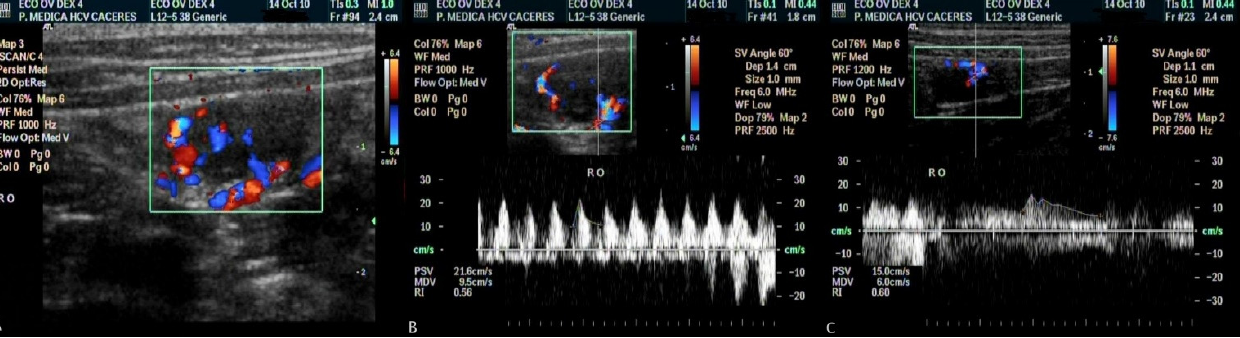
Figure 1. Colour flow Doppler image of intraovarian vascularization ( A ); spectral display of the Doppler signal from the right ovary before dexmedetomidine administration ( B ); spectral display of the same ovary after dexmedetomidine administration ( C ).